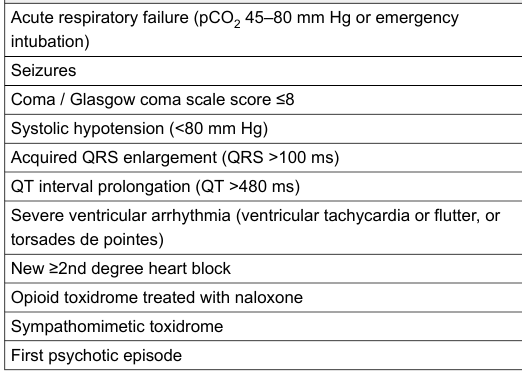
Table 1: Restrictive indications for toxicological screening in the emergency department for suspected overdose.